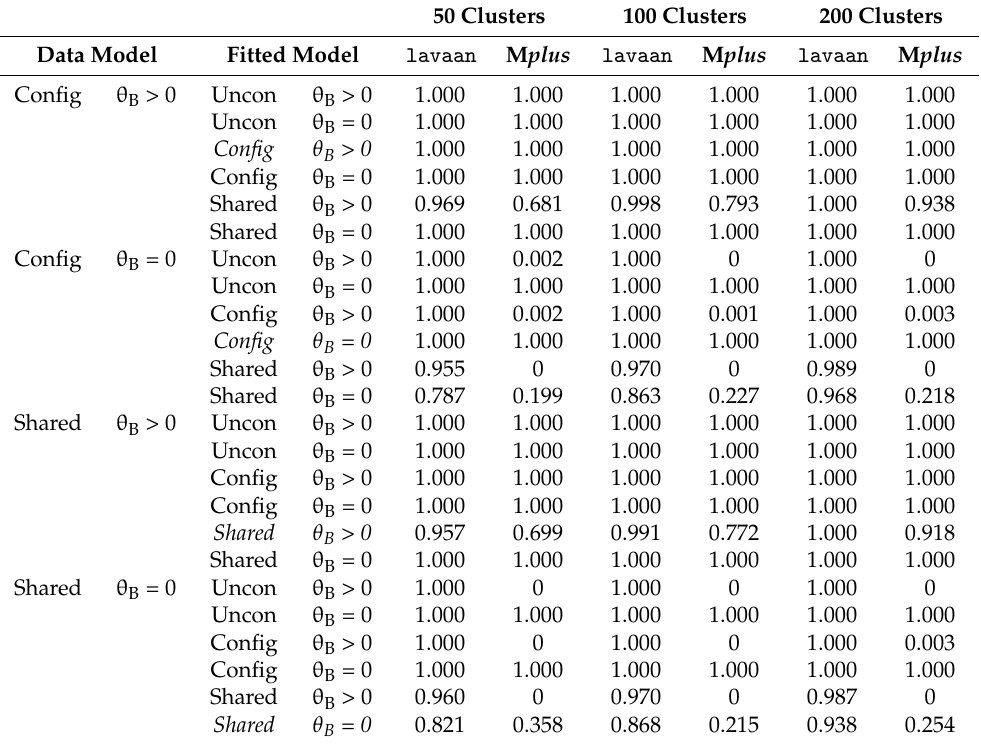
Table 3. Convergence rates for the six models in the four data conditions and three sample size